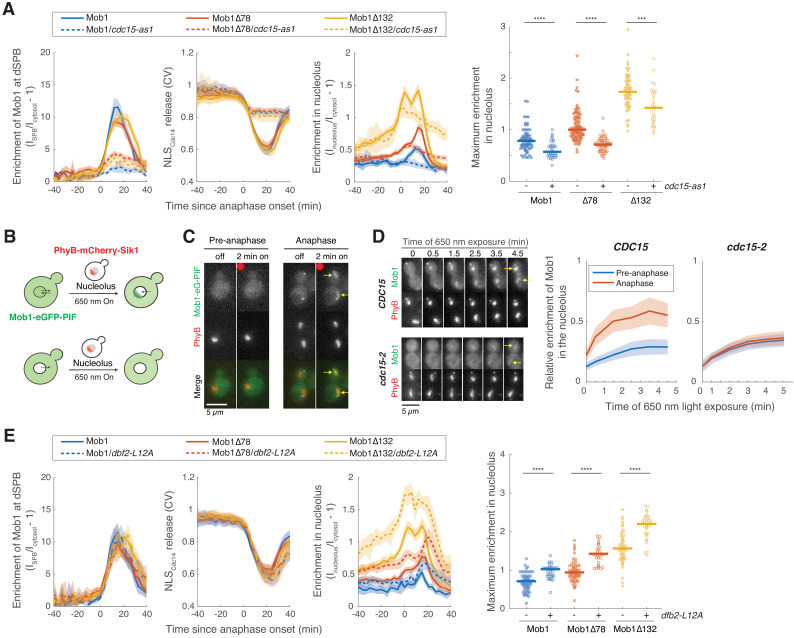
CDC15 regulates nuclear access of Dbf2-Mob1.(A) Enrichment of Mob1 at the daughter spindle pole body (dSPB), in the nucleolus, and Dbf2-Mob1’s kinase activity were determined in cells going through anaphase in CDC15 (A41211, A41212, and A41213; n = 74, 94, and 55 cells respectively) or cdc15-as1 (A41214, A41215, and A41216; n = 37, 63, and 30 cells respectively) cells. Cells were grown at 25°C in SC medium + 2% glucose and 10 μM 1-NA-PP1 and imaged every 3 min for 4 hr. (B) Probing Dbf2-Mob1’s nuclear access by recruiting Mob1 to the nucleolus with the PhyB-PIF optogenetics system. By anchoring PhyB to the nucleolus, diffuse nuclear Dbf2-Mob1, if present, can be visualized by recruiting Mob1-eGFP-PIF to the nucleolus. (C) Recruiting Mob1 to the nucleolus at different cell cycle stages. A40260 cells were grown at 25°C in SC medium + 2% glucose, imaged after a 2 hr incubation with 31.25 μM PCB in the dark. Red dot denotes the frame where 650 nm light was applied to activate PhyB. Yellow arrows highlight the light-induced recruitment. (D) Recruitment of Mob1 to the nucleolus in CDC15 (A41360) or cdc15-2 (A41361) cells. Quantifications of Mob1’s enrichment in the nucleolus as a function of PhyB activation time in CDC15 (A41360, n = 27 and 16 cells for pre-anaphase and anaphase respectively) or cdc15-2 (A41361, n = 14 and 36 cells for pre-anaphase and anaphase respectively) cells. Cells were grown at room temperature in SC medium + 2% glucose, incubated with 12.5 μM PCB for 2 hr in the dark, and shifted to 34°C for 50 min before imaging. (E) Nucleolar enrichment of full-length and truncated Mob1 in wild-type DBF2 or dbf2-L12A cells (A41394, A41395, and A41396; n = 32, 28, and 31 cells respectively). Wild-type traces for comparison were the same as in Figure 1E. Cells were grown similarly as in Figure 1E. For graphs in (A) and (E), solid lines represent the average of single cell traces aligned to anaphase onset. Shaded areas represent 95% confidence intervals. For maximum enrichment, each dot represents a single cell. Solid lines represent the median. ****p<0.0001; ***p<0.001 by two-sided Wilcoxon rank sum test.